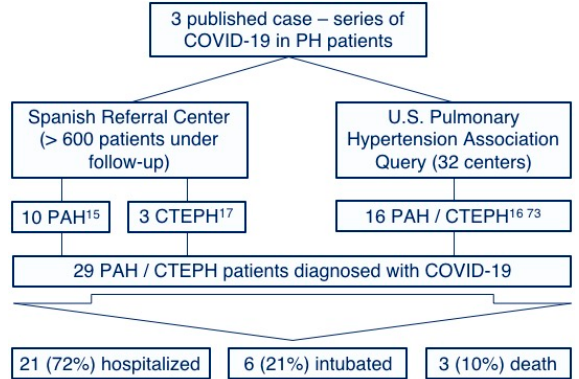
Figure 2. Reported cases and outcomes of the coronavirus disease of 2019 among pulmonary arterial hypertension and chronic thromboembolic pulmonary hypertension patients. PH: pulmonary hypertension, PAH: pulmonary arterial hypertension and CTEPH: chronic thromboembolic pulmonary hypertension.